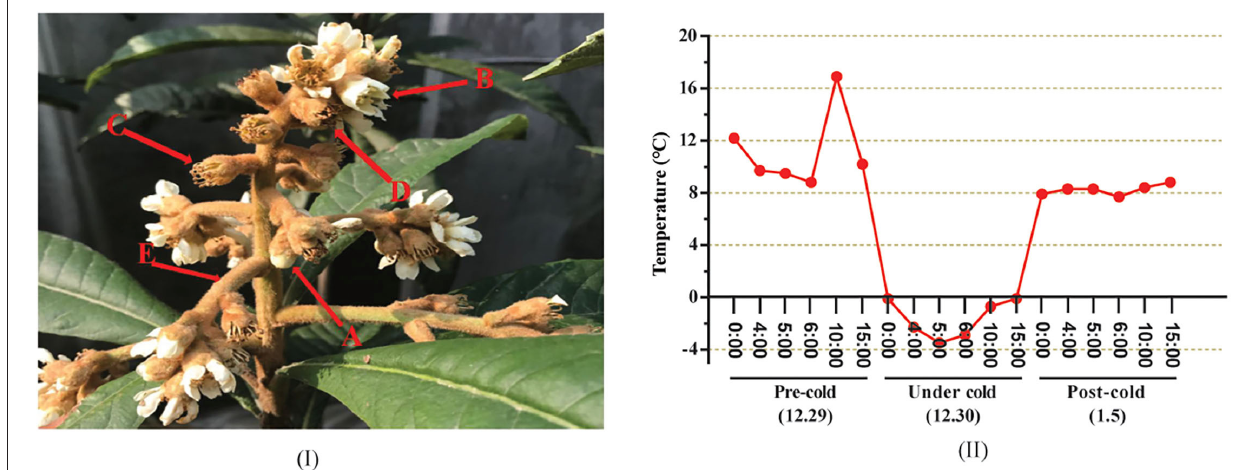
FIGURE 1 | Schematic diagram of different organs of loquat inflorescence and dynamics changes of temperature ( ◦ C) at different time points of samples collected. (A–D) indicates the different developmental stages of floral organ (A, showing-white flower; B, blooming flower; C, unclosed calyx; D, closed calyx). (E) indicates the rachis of inflorescence; The temperatures during the period of 0:00–15:00 on 29 December (pre-cold) were all above 8 ◦ C and the maximum temperature reached 17 ◦ C (10:00 am); the temperatures throughout the day on 30 December (under cold) were all below 0 ◦ C, the lowest temperature drop to − 3.5 ◦ C (5:00 am); the average temperature during the period of 0:00–15:00 on 5 January (post-cold) invariably maintained at 8 ◦